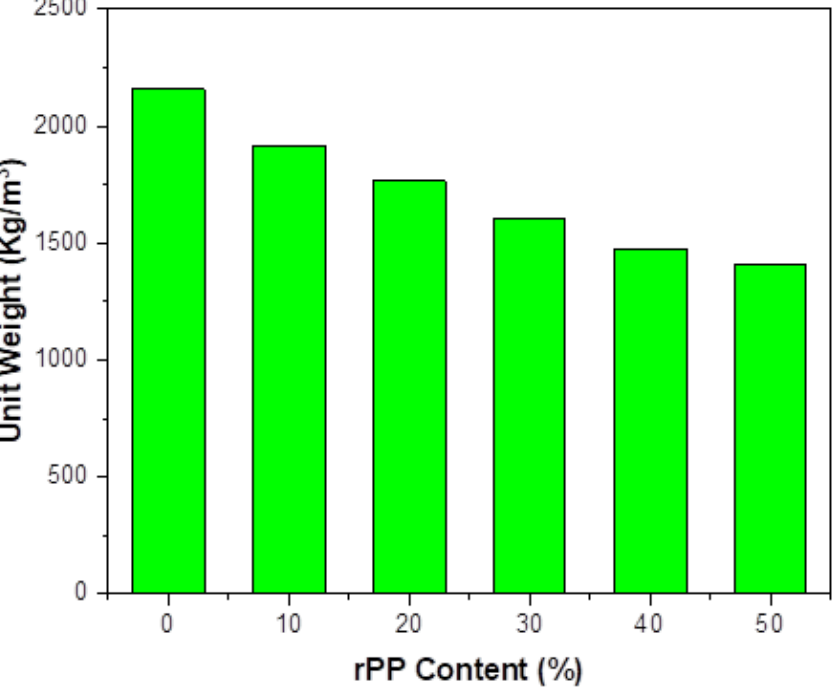
Figure 3. rPP addition effect on fresh unit weight of concrete.